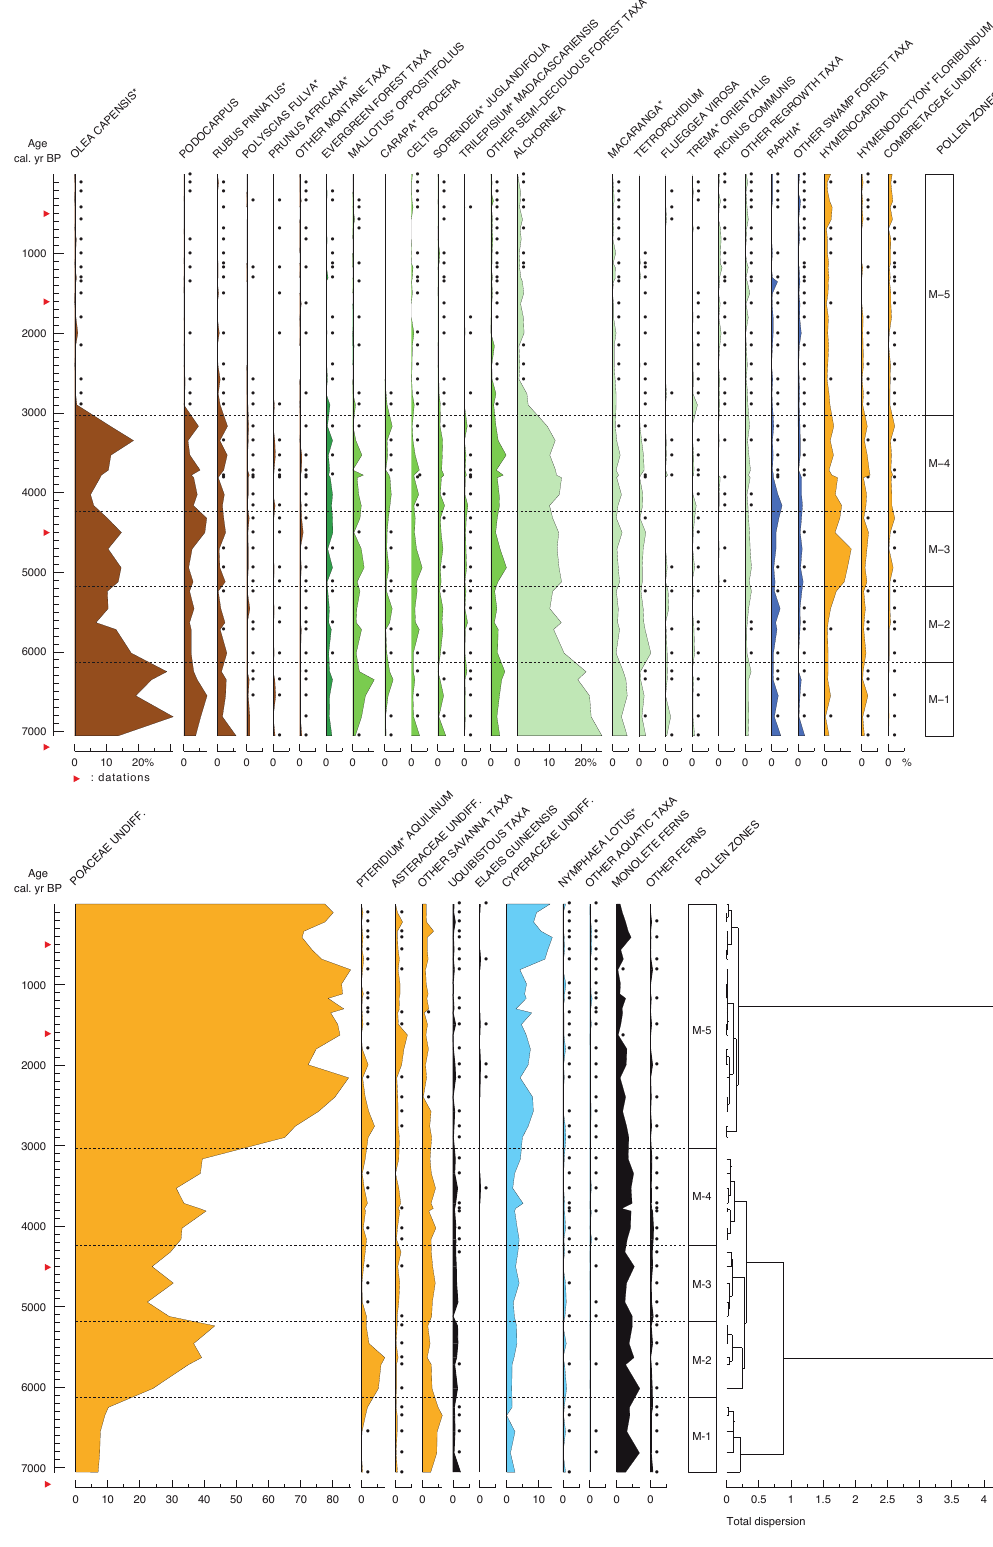
Fig. 3. The M4 pollen diagram for Lake Mbalang, Central Cameroon, showing relative percentages of selected taxa (the pollen sum includes all identified pollen and spore taxa, excluding Bryophyta and indeterminable grains. Dots are percentages <